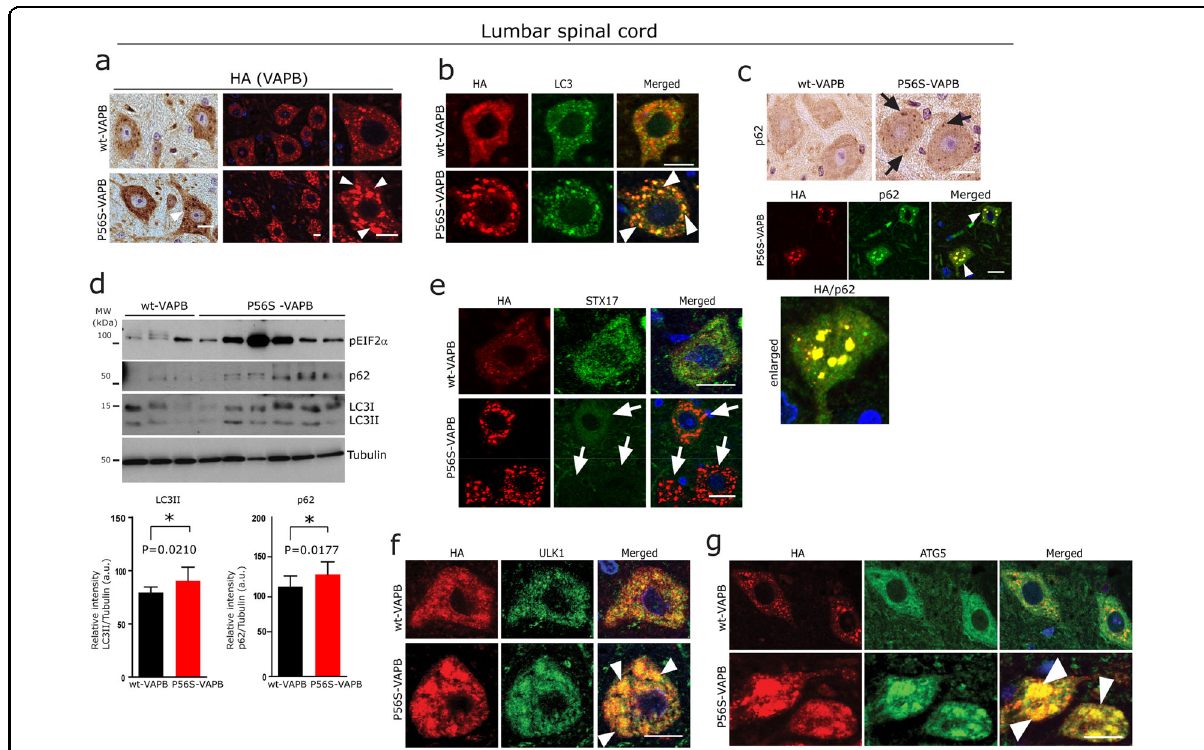
Fig. 4 Autophagy defects in P56S-VAPB transgenic mice. a Representative DAB immunohistochemistry (Left panel) and immuno fl uorescence staining (right panel) using HA antibody in lumbar spinal cord α -MNs of wt and P56S-VAPB tg mice, showing globular aggregates in the α -MNs (arrowheads) of P56S-VAPB tg mice. Scale bars: 15 µm. b , c Double immuno fl uorescence labelling for HA and for the autophagy marker LC3 ( b ) and p62 lower panel showing co-localisation (arrowheads) with P56S-VAPB aggregates ( c ), and DAB immunohistochemistry showing globular accumulations of p62 (arrows, upper panel) ( c ) in lumbar spinal cord α -MNs, Scale bars: 15 µm. d Immunoblot analysis of lumbar spinal cord homogenates from P56S-VAPB ( n = 6, male, 200 days) and their age-matched wt-VAPB mice ( n = 3, male, 201 days), showing an overall increased level of ER stress markers pIF2 α and autophagy markers p62 and LC3 in P56S-VAPB tg mice. Corresponding densitometric data are shown at the bottom; representing the average relative band intensity from n = 3 wt-VAPB and n = 6 P56S-VAPB of p62, LC3-II/LC3-I normalised with tubulin levels. Unpaired Student ’ s t test for comparison between these two sample groups (average, n = 3 wt-VAPB mice and average, n = 6 P56S-VAPB mice) Values were expressed as mean ± standard error of mean (SEM) from three independent blots. The asterisks (*) denote signi fi cant differences (* p < 0.05). e – g Double immuno fl uorescence labelling for HA and for the SNARE protein STX17 ( e ), early autophagy proteins ULK1 ( f ) and ATG5- ATG12 ( g ) showing their co-localisation (arrowheads) with P56S-VAPB aggregates in lumbar spinal cord α -MNs. Note the loss of STX17 immunoreactivity (arrows in e ) in α -MNs harbouring P56S-VAPB aggregates in lumbar spinal cord of P56S-VAPB mice. Scale bars: 15